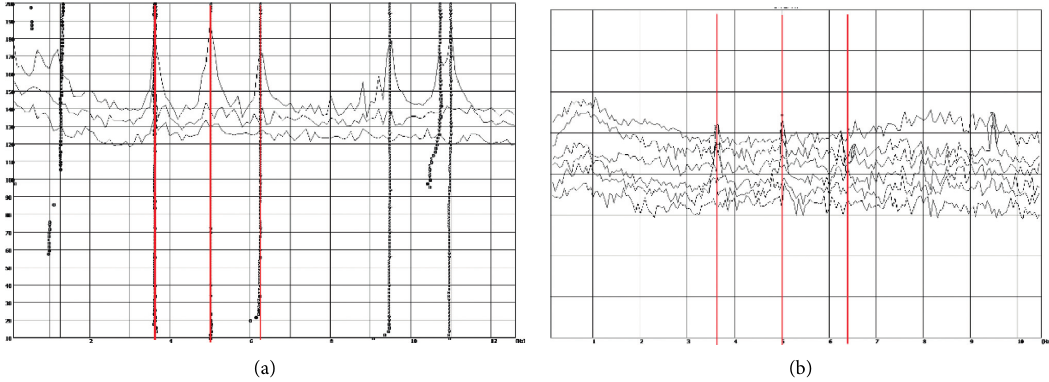
Figure 5: The pictures with two different techniques. (a) Stability diagram for SSI. (b) Singular value for EFDD.